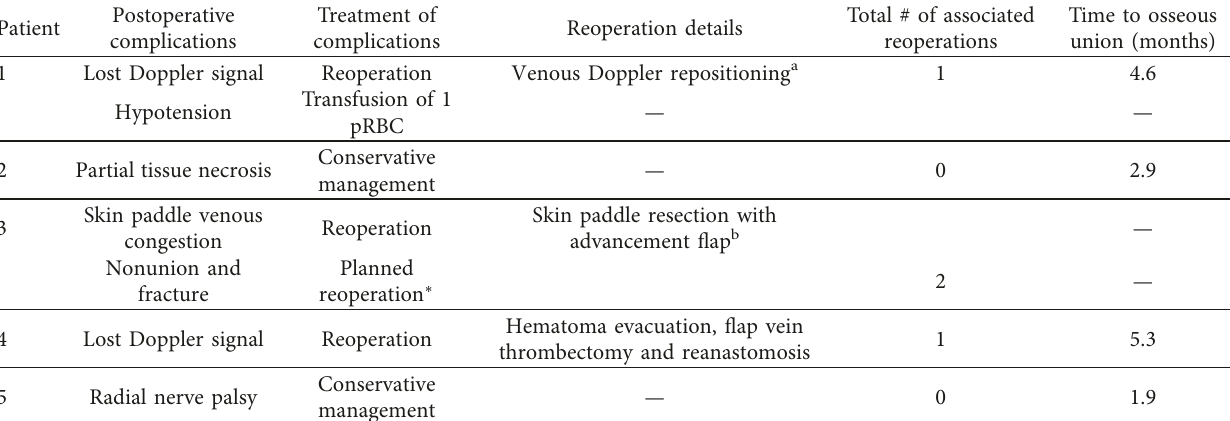
Table 3: Postoperative course and associated complications.